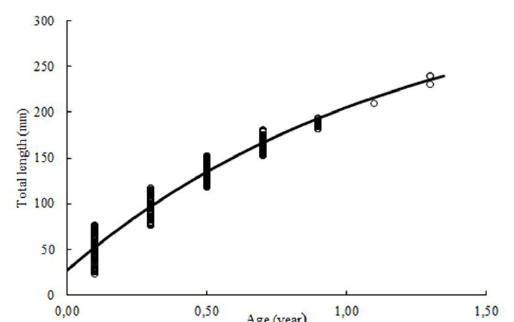
Figure 6. Growth curve according to the von